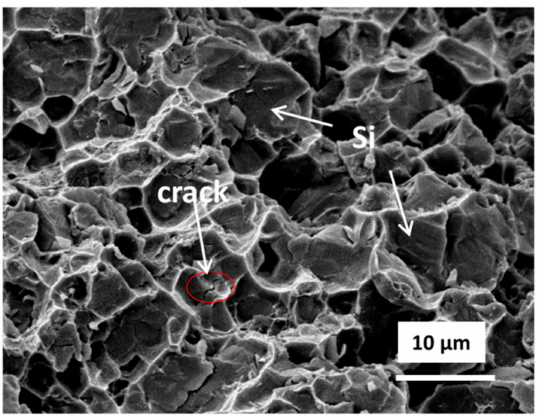
Figure 11. SEM image of tensile fracture surface of sintered part.